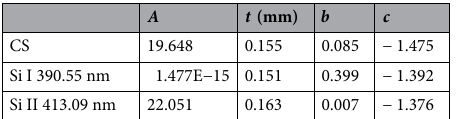
Table 2. EA fitting results of different spectral